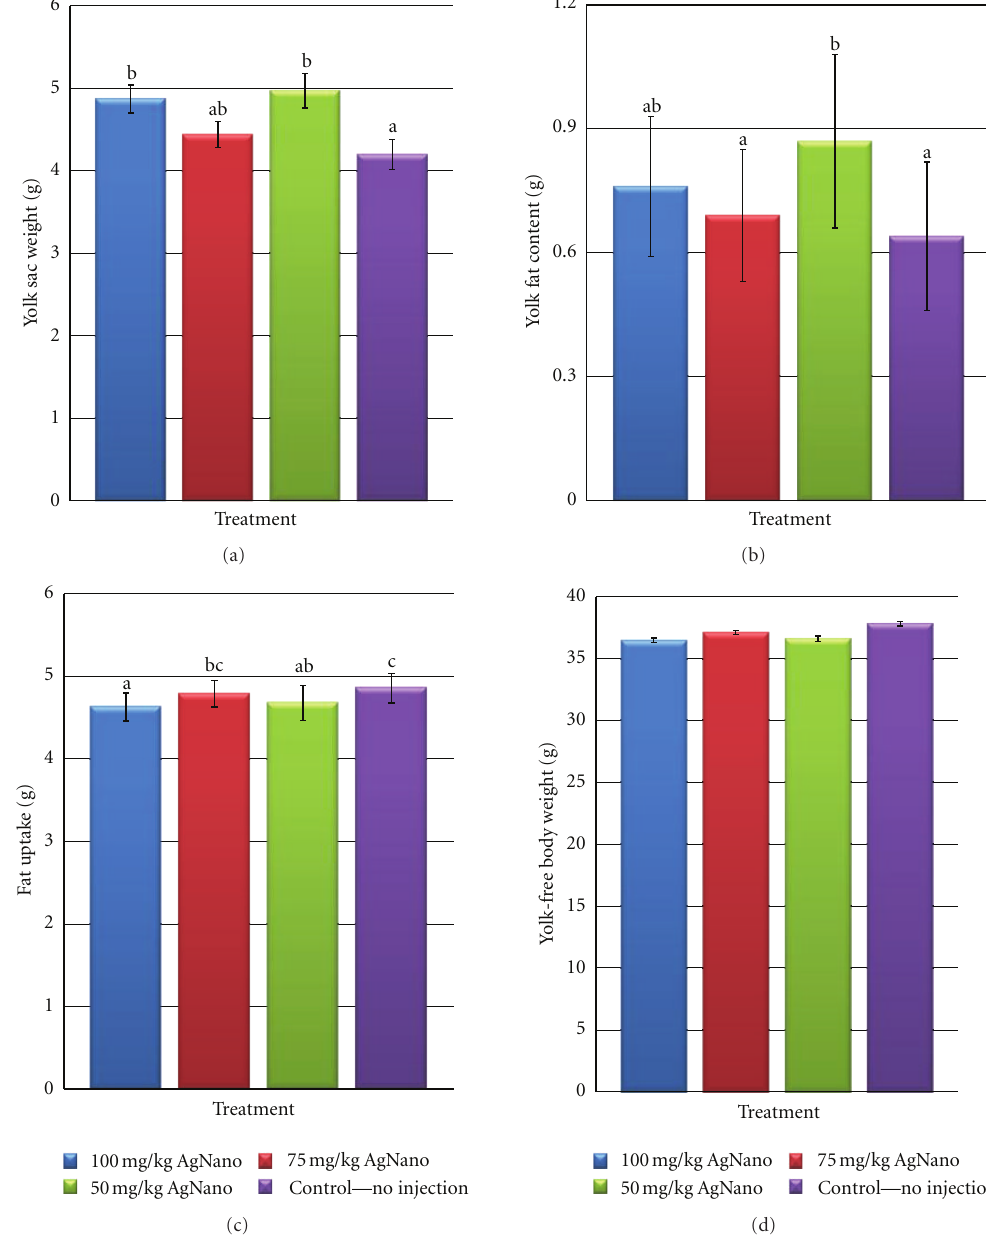
Figure 1: Comparison of (a) yolk sac weight (YS), (b) yolk fat content (YF), (c) fat uptake (FU), and (d) yolk-free body weight (YFBW) of hatchlings in ovo injected with di ff erent concentrations of AgNano (50, 75, and 100mg/kg) and the control (no injection) at 24 h after hatching. Mean values and standard errors of 4 treatments, each containing 10 chicks. a,b,c Significant di ff erence ( P < 0 . 05) between